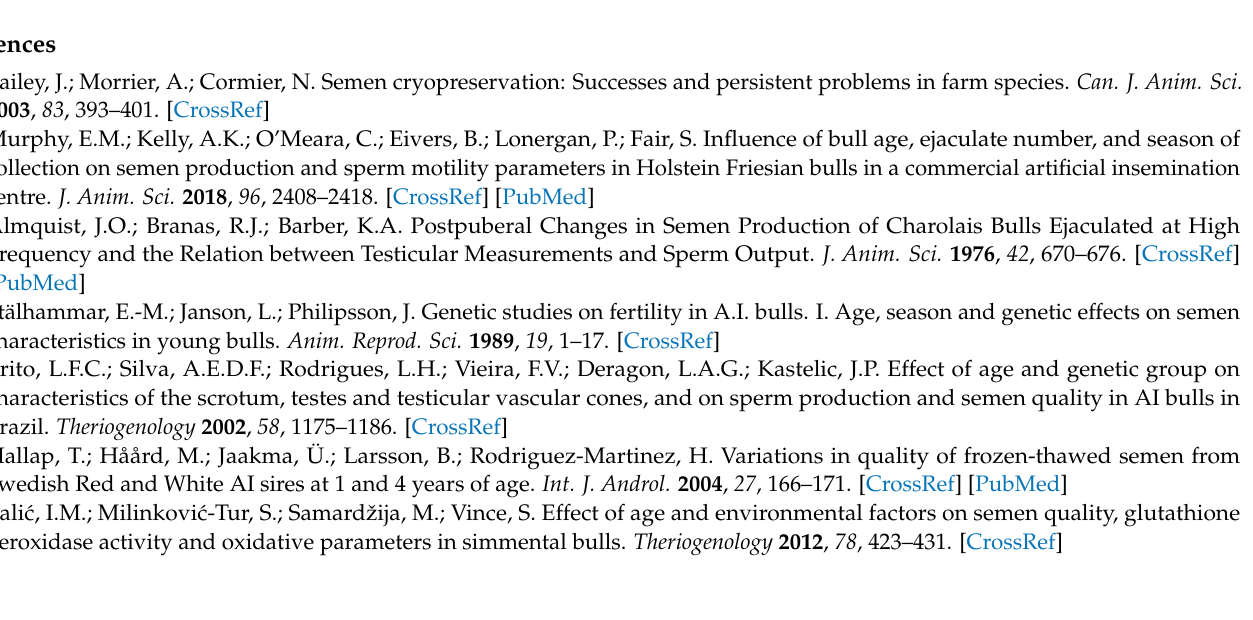
Table S3: Molecular and cellular functions performed by proteins changing in adult bulls supernatant of thawed semen in comparison to young bulls supernatant of thawed